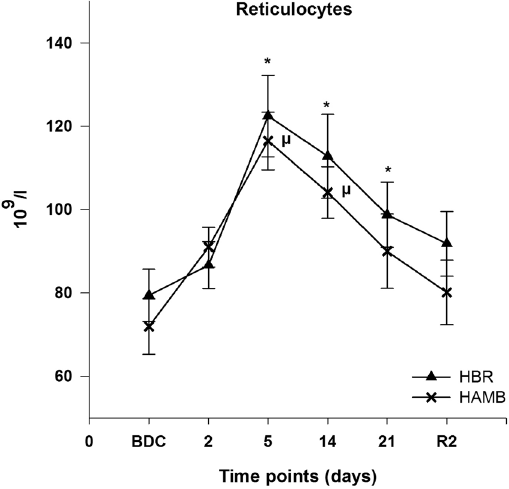
Figure 4. Reticulocyte count; data are means ± SEM; units are 10 9 /l; HBR = hypoxic bed rest (n = 11); HAMB = hypoxic ambulation (n = 11); BDC = Baseline Data Collection; R2 = 2 days after the end of condition; * Significant difference to BDC in HBR; µ Significant difference to BDC in HAMB (p <